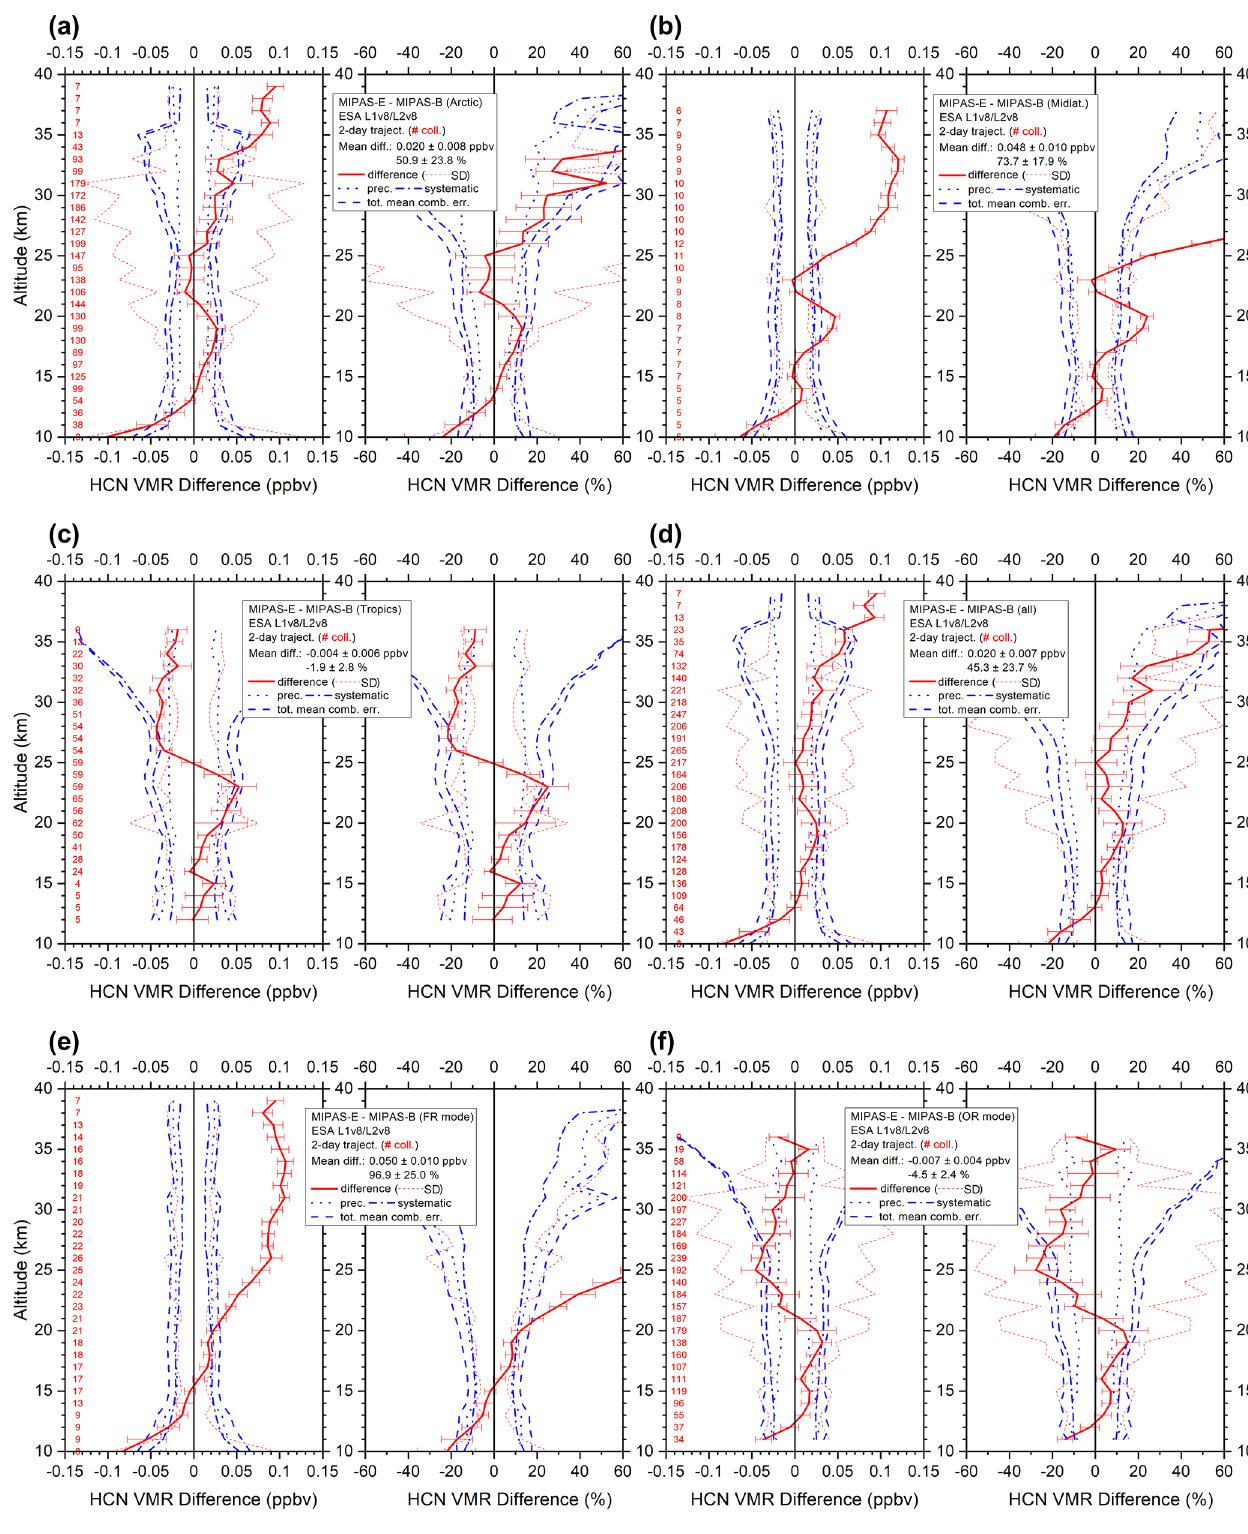
Figure 17. Same as Fig. 3 but for